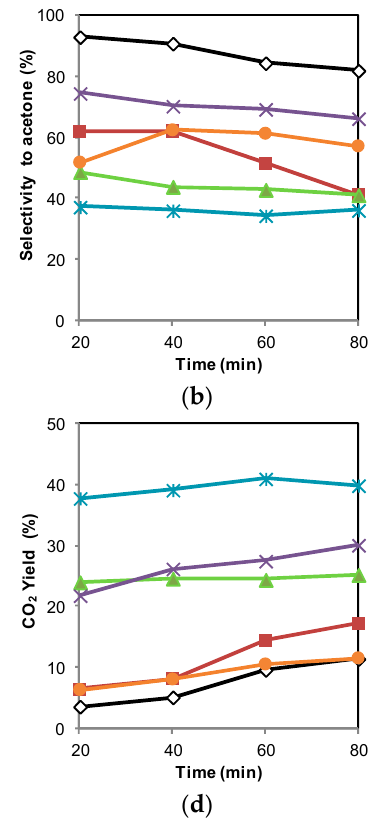
Figure 1. Photocatalytic H 2 production at 30 °C under ultraviolet (UV) irradiation over: TiO 2 ( ), CeO 2 ( ), TiO 2 ‐ 10%CeO 2 ( ), Au/TiO 2 ( ), Au/CeO 2 ( ) and Au/TiO 2 ‐ 10%CeO 2 ( ).